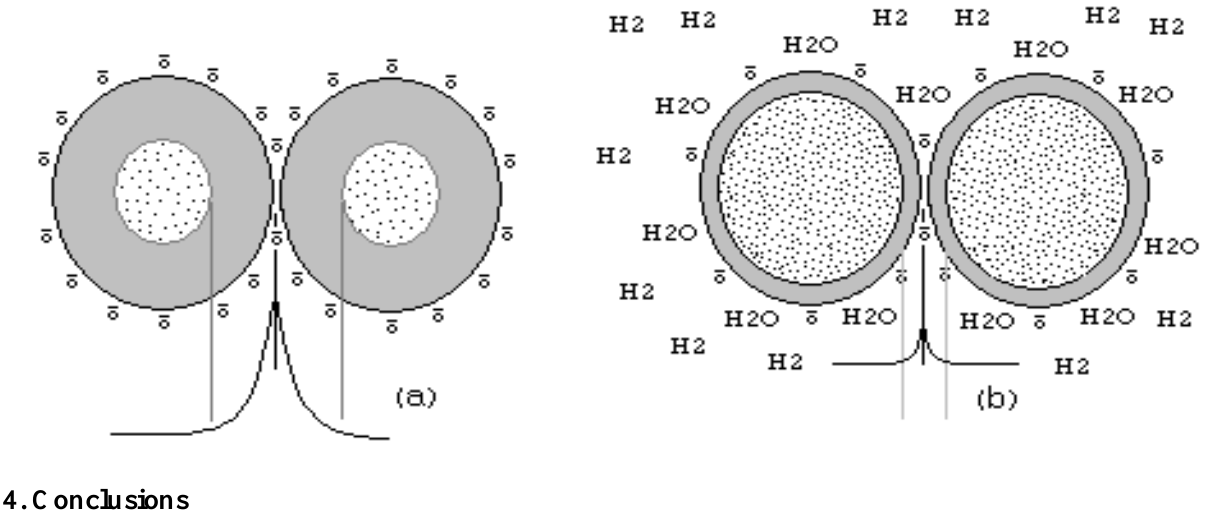
Figure 7. Hydrogen sensing mechanism of WO ( b ) after hydrogen